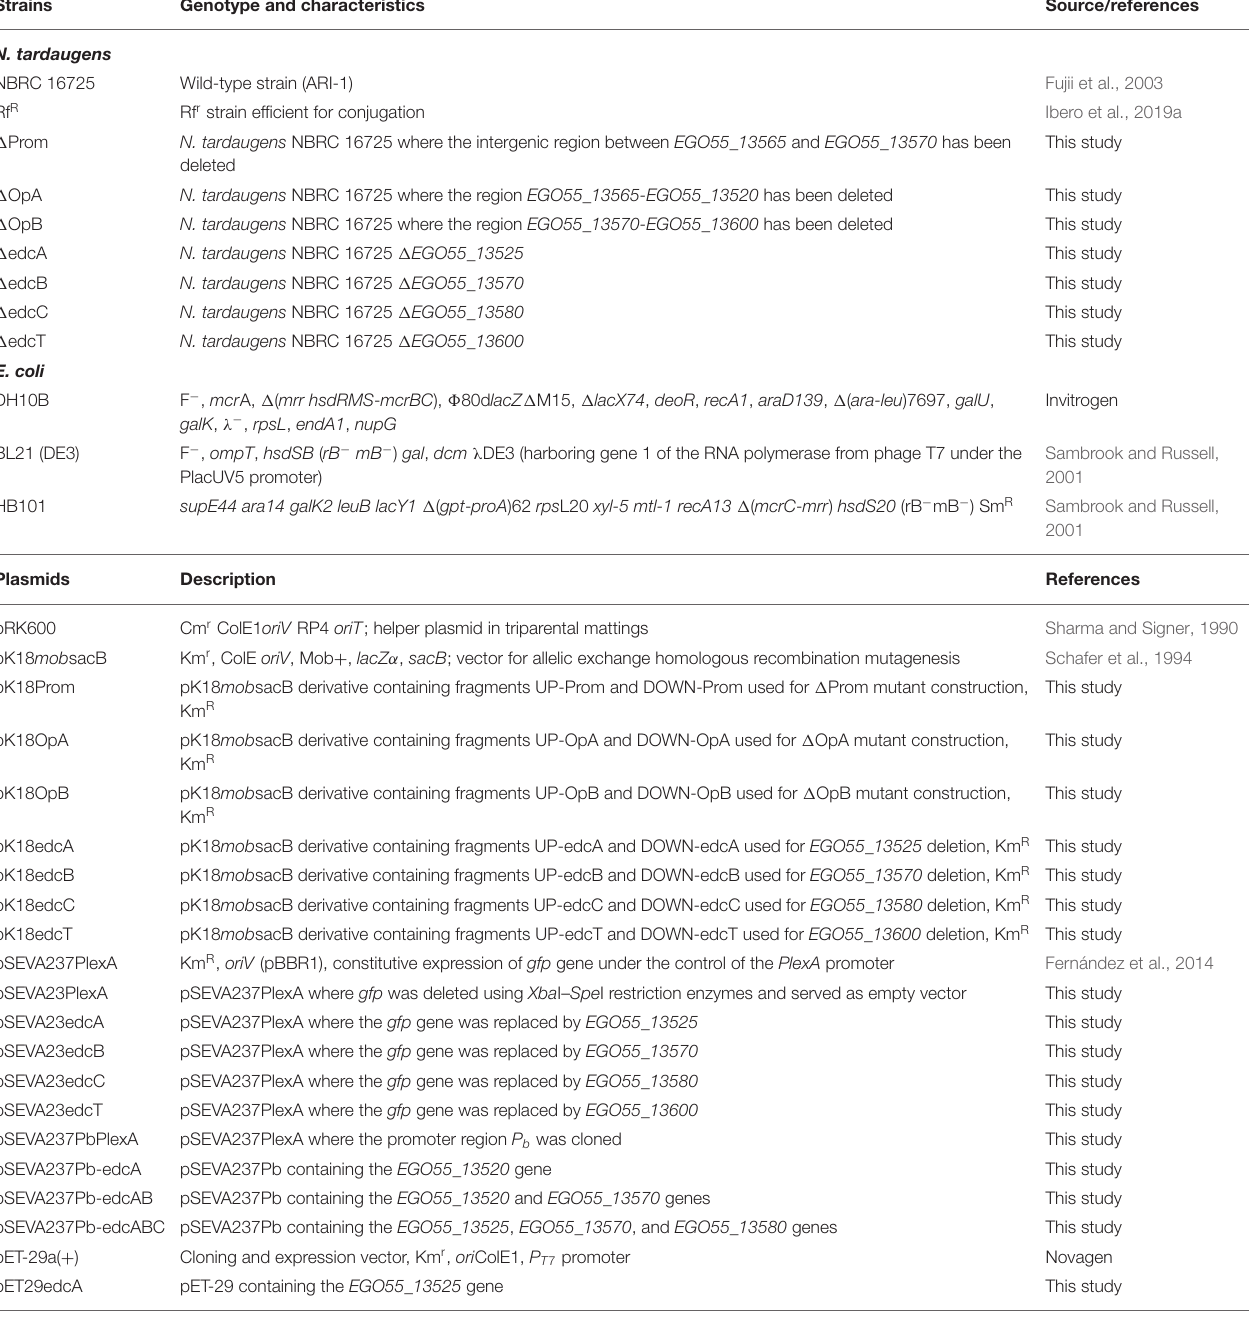
TABLE 1 | Bacterial strains and plasmids used in this